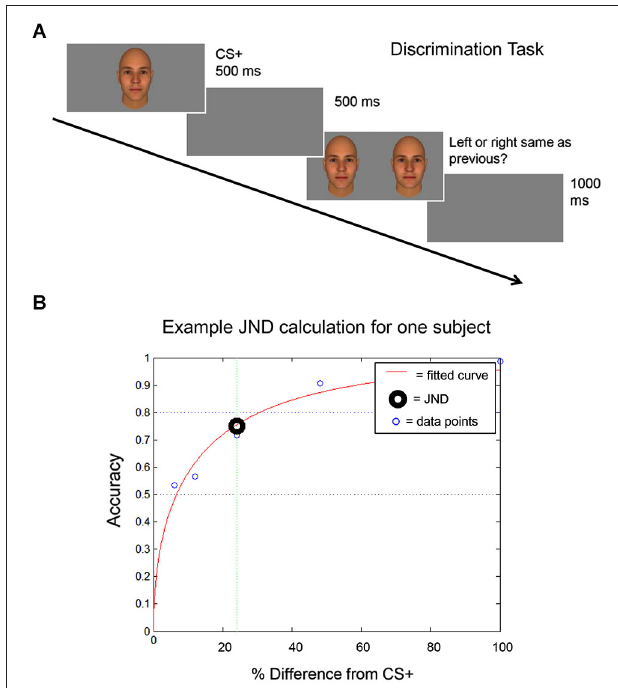
FIGURE 2 | Discrimination task . (A) A schematic of the discrimination task used to identify each subject’s discrimination threshold (the Just Noticeable Difference (JND) level) is shown. The CS+ stimulus is shown and then, following a 500 ms inter-trial interval (ITI), the CS+ stimulus is shown next to a morph stimulus. (B) An example is shown of the curve that is generated using each subject’s performance on the discrimination task, to calculate each subject’s JND. The JND was then used to select the morph stimuli that were presented to that subject during the fear generalization procedure (see Materials and